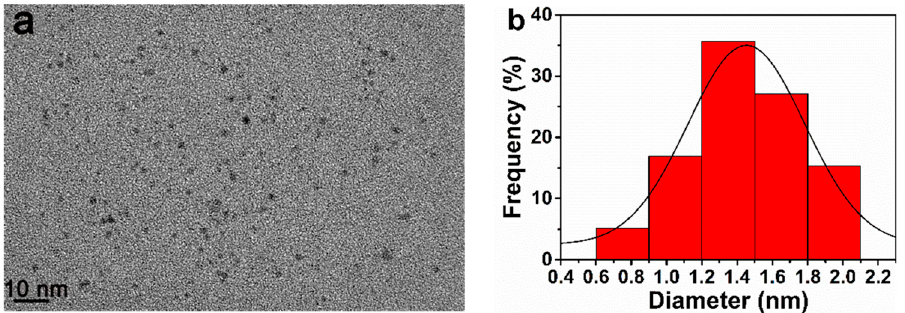
Figure 4. ( a ) HRTEM image and ( b ) histogram of Pt 600 -GLP NCs. The hydrodynamic size and zeta potential of Pt n -GLP NCs were measured using DLS technology [30]. As shown in Figure 5a, the hydrodynamic size was 17.63 ± 1.45 nm for Pt 600 -GLP NCs, 18.18 ± 0.03 nm for Pt 1000 -GLP NCs, and 19.61 ± 2.87 nm for Pt 1400 -GLP NCs, respectively. The hydrodynamic size of Pt n -GLP NCs included the GLP molecule, which was much bigger than the size of Pt NCs as measured using TEM. Furthermore, the zeta potential of Pt n -GLP NCs was also measured in water. GLP is a chain compound with a triple-helical structure. Figure 5b shows that the zeta potential was − 12.93 ± 2.59 mV for Pt 600 -GLP NCs, − 15.1 ± 1.37 mV for Pt 1000 -GLP NCs, and − 14.08 ± 1.15 mV for Pt 1400 -GLP NCs, respectively. Thus, Pt n -GLP NCs had a hydrodynamic size from 17.6 to 19.6 nm and a slightly negative charge